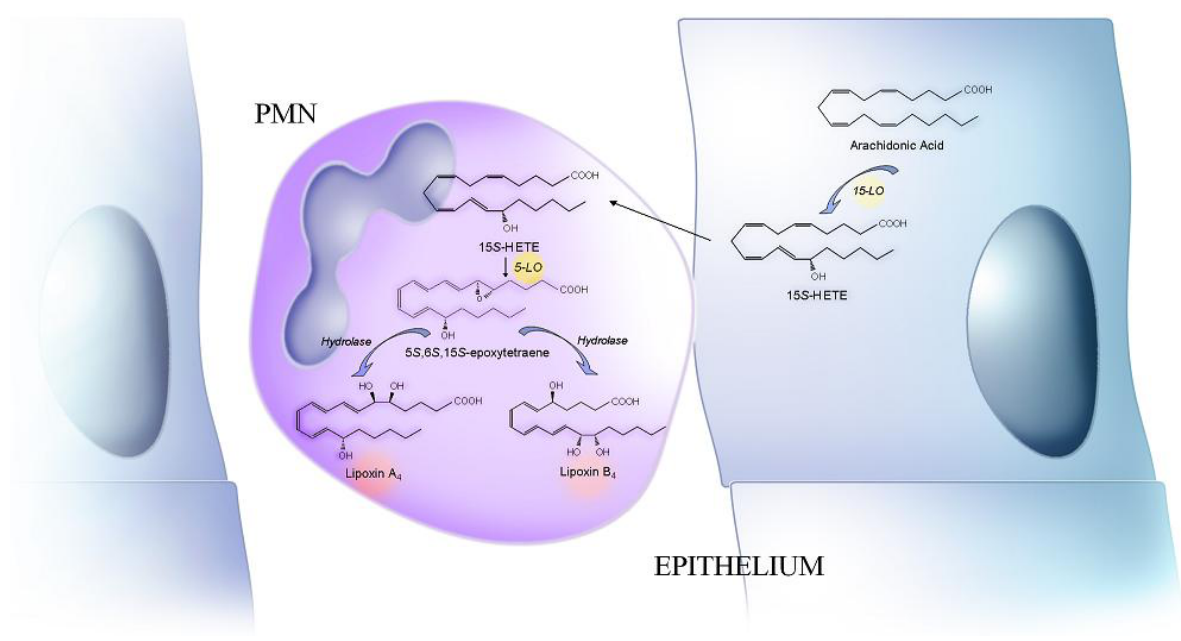
FIGURE 2B. The 5-/15-LO pathway of lipoxin biosynthesis during interactions between PMNs and epithelial